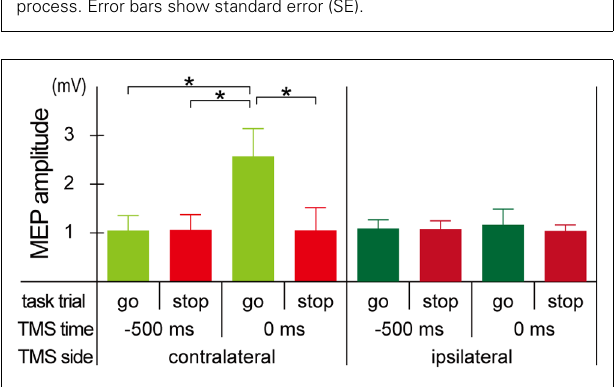
FIGURE 3 | Motor-evoked potential (MEP) amplitude. Group means ( ± SE) of MEP amplitudes during the go/stop task with contralateral (upper) and ipsilateral (lower)TMS at − 500 and 0 ms. Error bars show standard error (SE). ∗ p < 0.05; significant difference in post hoc multiple comparisons with Bonferroni corrected paired t